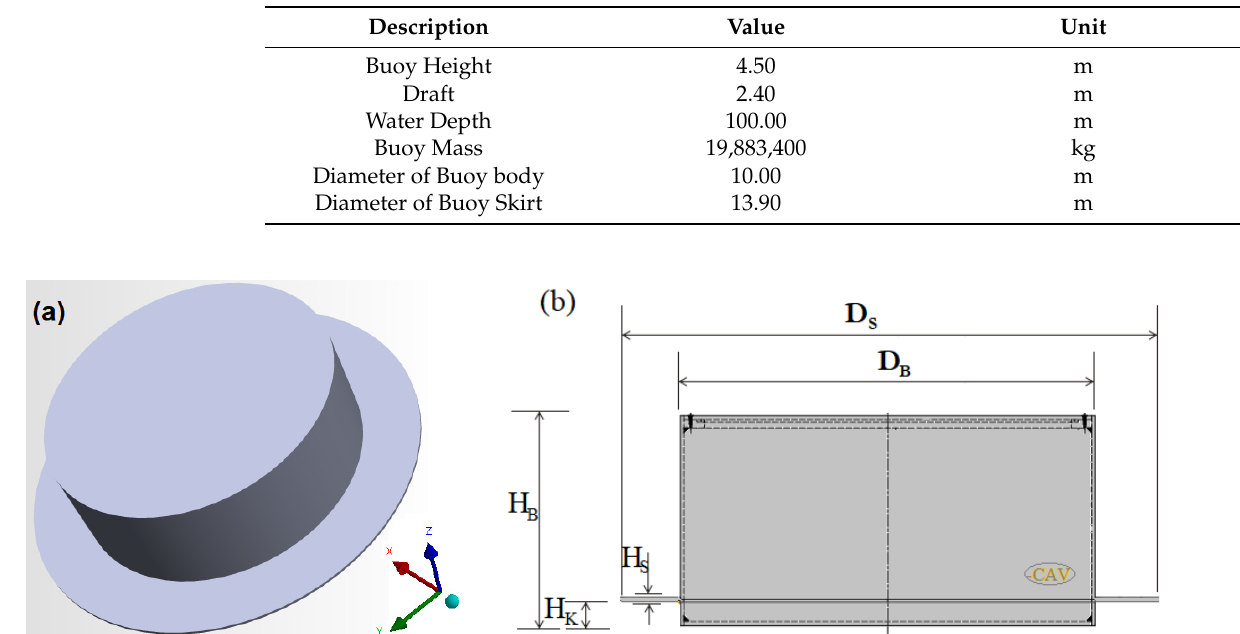
Figure 4. Description of the geometry for the first concept of CALM Buoy and skirt, showing ( a ) an isometric view and ( b ) a plan view.